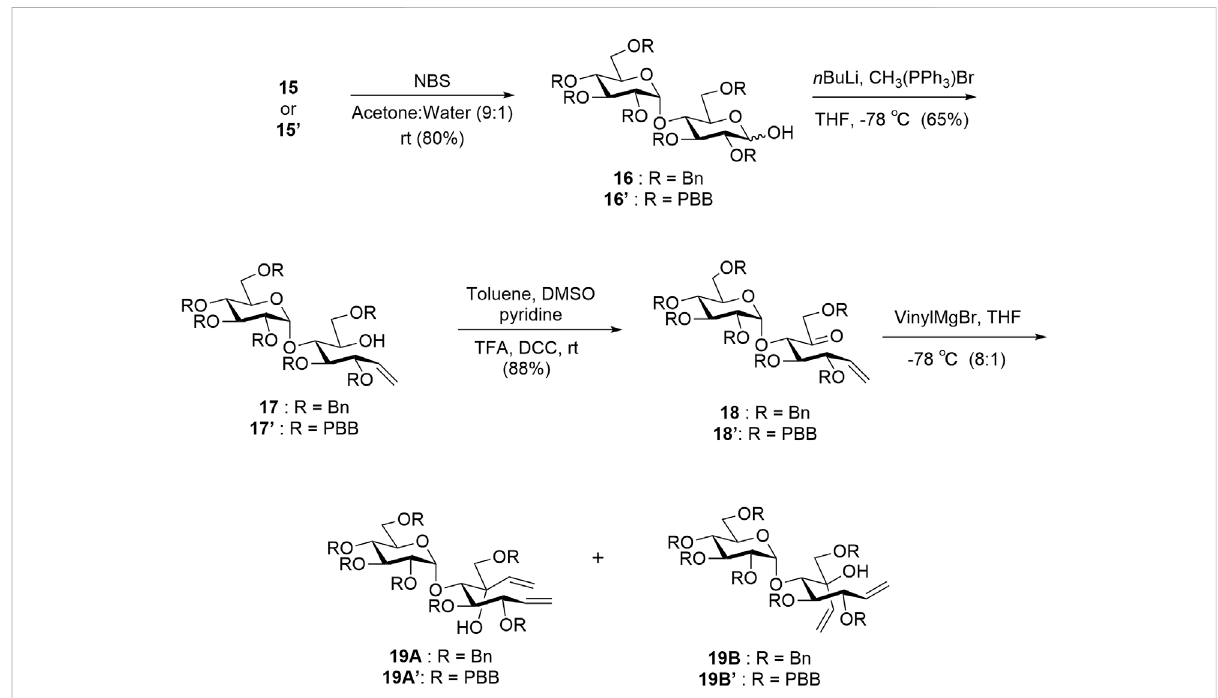
(Figure 5). The difference density maps show strong density for the glucose moiety in the -2 subsite and the carbocycle in the − 1 subsite. However, the cyclohexyl moiety of compound 13 exhibits only weak difference density suggesting a lack of suf fi cient binding interactions with the residues forming the Sco GlgEI-V279S +1 site. This is consistent